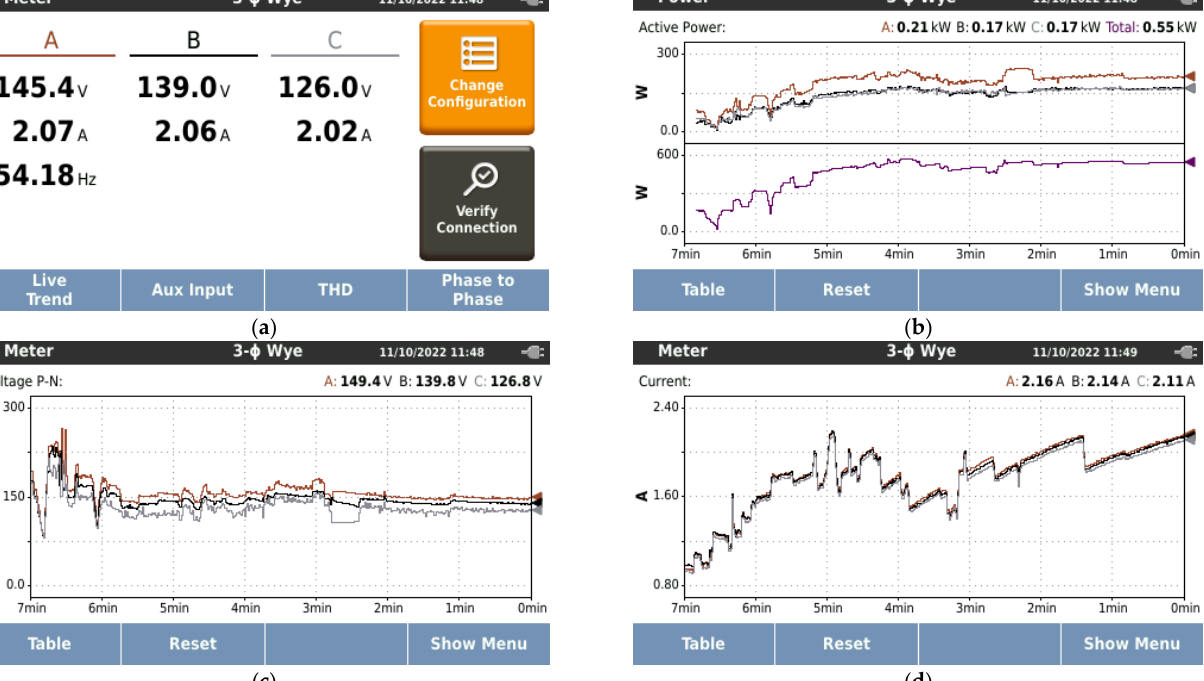
Figure 19. Speed variation effect on ( a ) power, ( b ) current, ( c ) power factor, and ( d ) voltage using the supplementary voltage source.